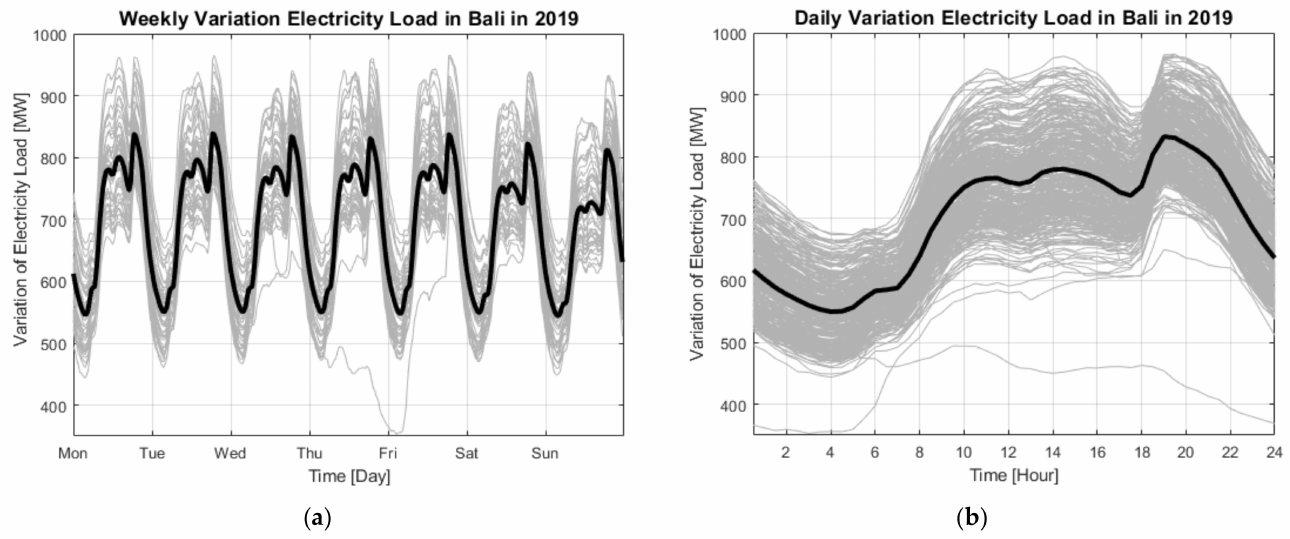
Figure 2. Variations of electricity load in Bali during 2019: ( a ) Weekly variation; ( b ) Daily variation. The solid black lines denote the mean value, whereas the gray lines denote the